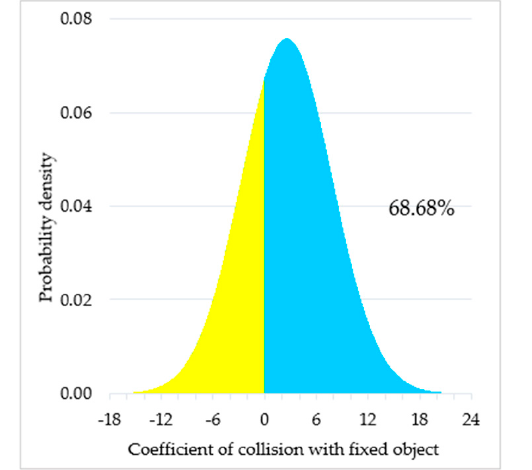
Figure 2. Distribution of the random